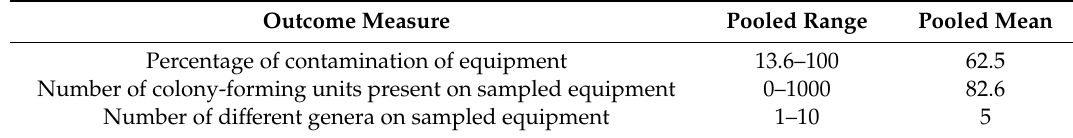
Table 4. Pooled range and mean for each outcome measure investigated [32].